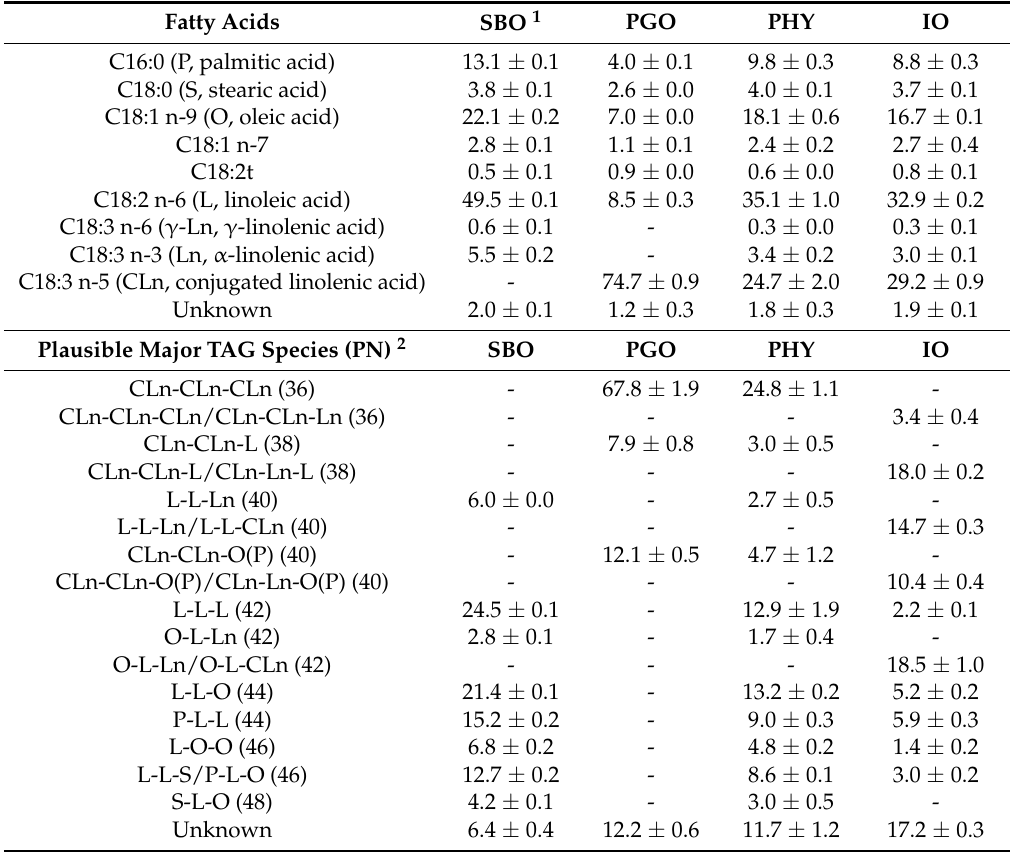
Table 2. Fatty acid compositions and profiles of plausible triacylglycerol species (peak